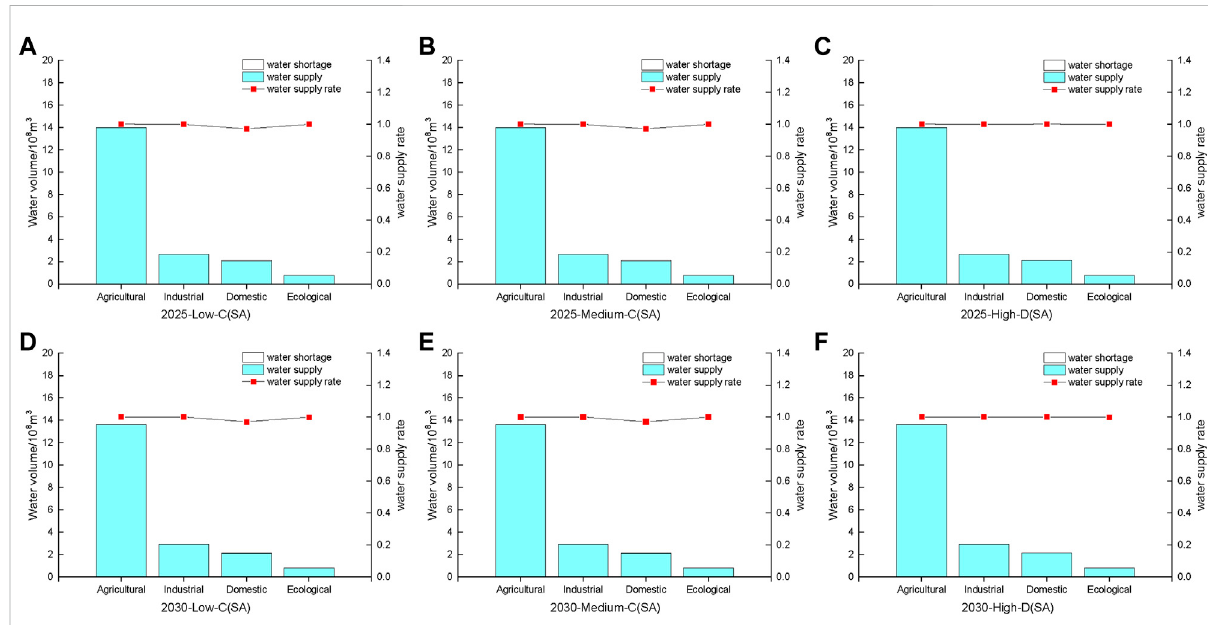
FIGURE 9 Distribution of water resources for six suitable scenarios in Sunkou-Aishan section [ (A – F) represent 6 selected scenarios respectively].